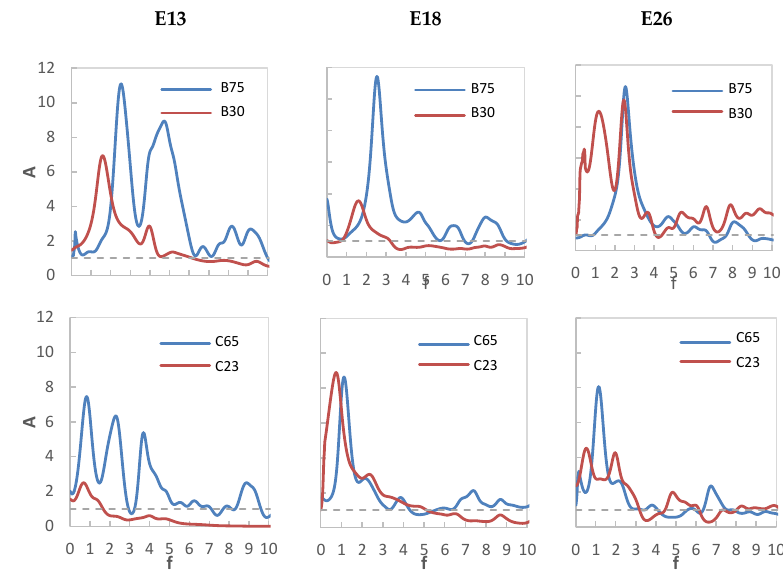
Figure 8. Comparison between the amplification functions obtained for the FF alignment.